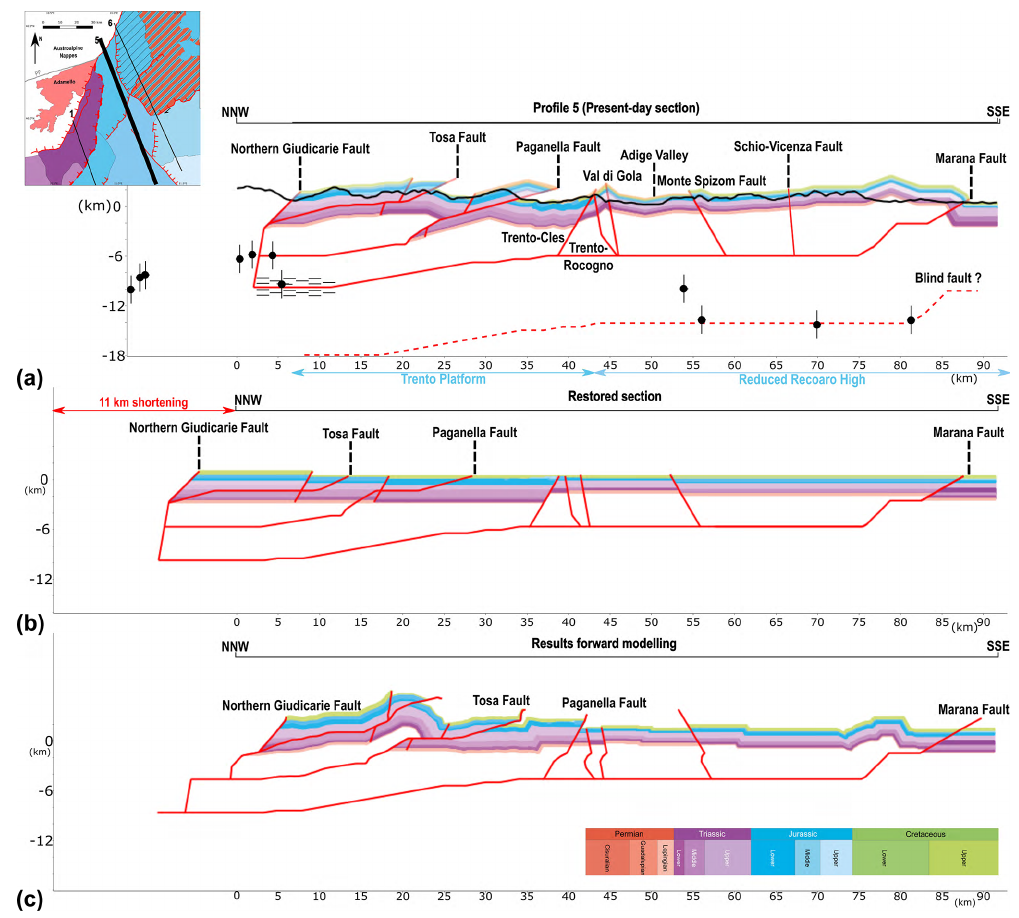
Figure 8. (a) Profile 5 across the Trento Platform and its structural Recoaro High. (b) Profile 5 retro-deformed to a layer-cake stratigra- phy. (c) Results of forward modelling. Colours in the legend are modified following the International Chronostratigraphic Chart, with the pre-Permian basement beneath in white. Black dots indicate hypocentres of seismic events during 2017–2018 (SWATH-D Network; Jozi Najafabadi et al., 2021; vertical bars indicate the average error range on hypocentre depths), projected from a swath covering 6km on either side of the profile. Dashed black lines below ∼ 10km indicate ductile